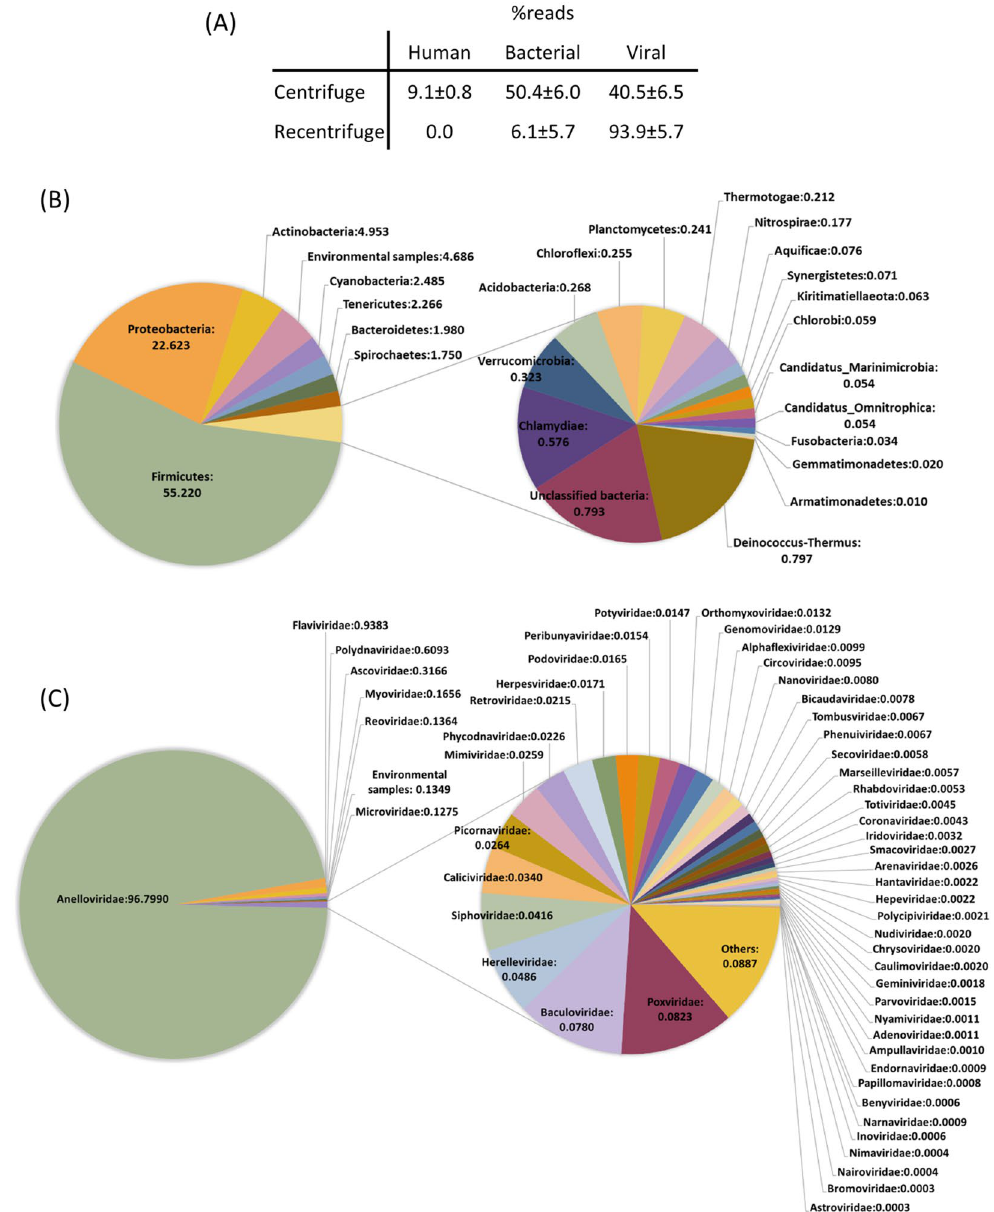
Figure 2. Summary of bioinformatics subtraction (i.e. mean frequency of reads (± SEM) before and after using Recentrifuge for the twelve analyzed pools) for human, bacterial and viral groups ( A ) and description of the microbiome ( B ) and the virome ( C ) characterized in this study. Classification is shown for bacteria and viruses at phylum and family level, respectively. Frequencies were obtained excluding spiked virus contribution in ( A , C )